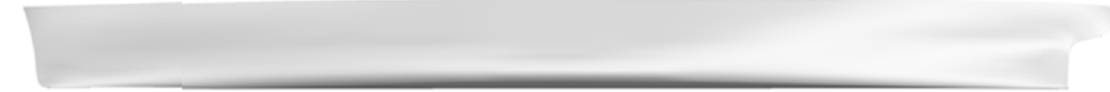
Figure 3. Schematic of a 3D model of Series 60.